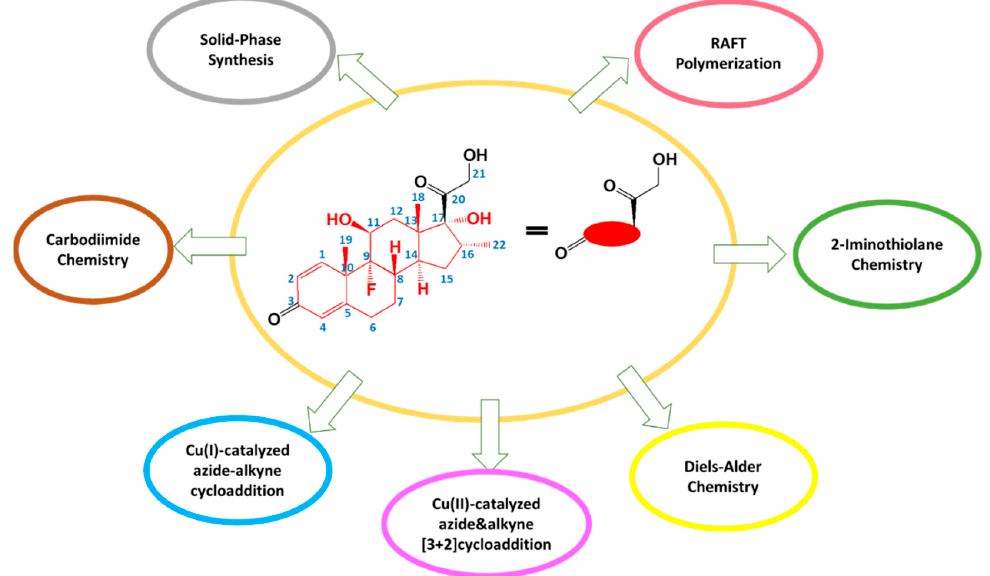
Figure 3. Methods for the synthesis of dexamethasone conjugates.